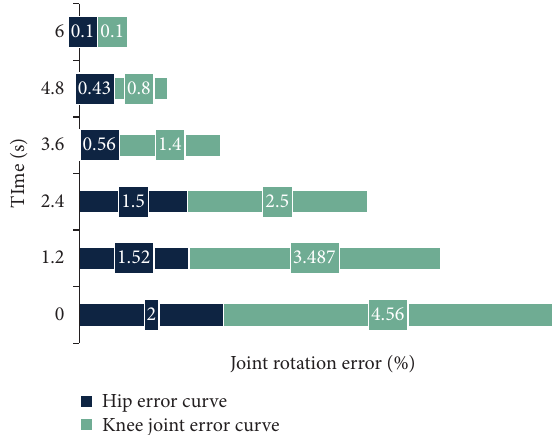
Figure 7: The change of gait trajectory tracking error in iterative learning control